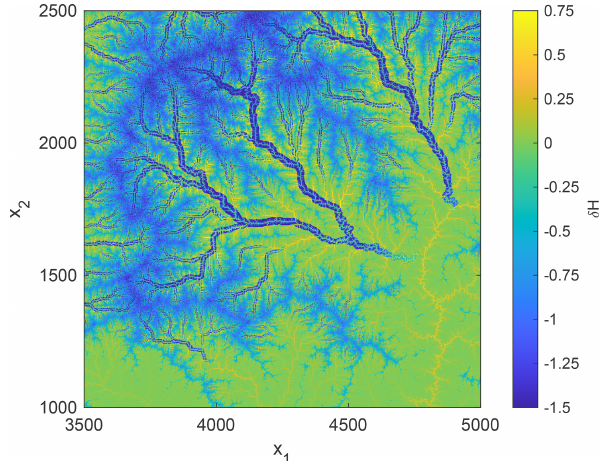
Figure 12. Change in surface height compared to the initial flu- vial topography (black square in Fig. 3) obtained from the shared stream-power model with a thickness-to-width ratio of 0.05 at the time when the ELA reaches H e = 8.